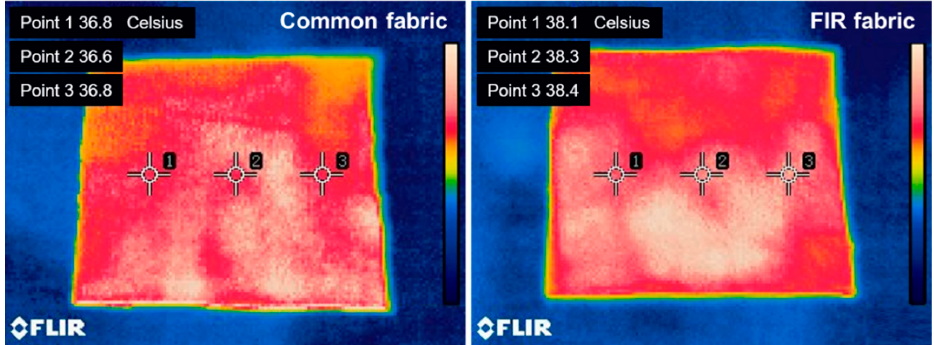
Figure 3. Thermal images of common fabric ( left ) and FIR fabric ( right ) under the thermal equilibrium state.